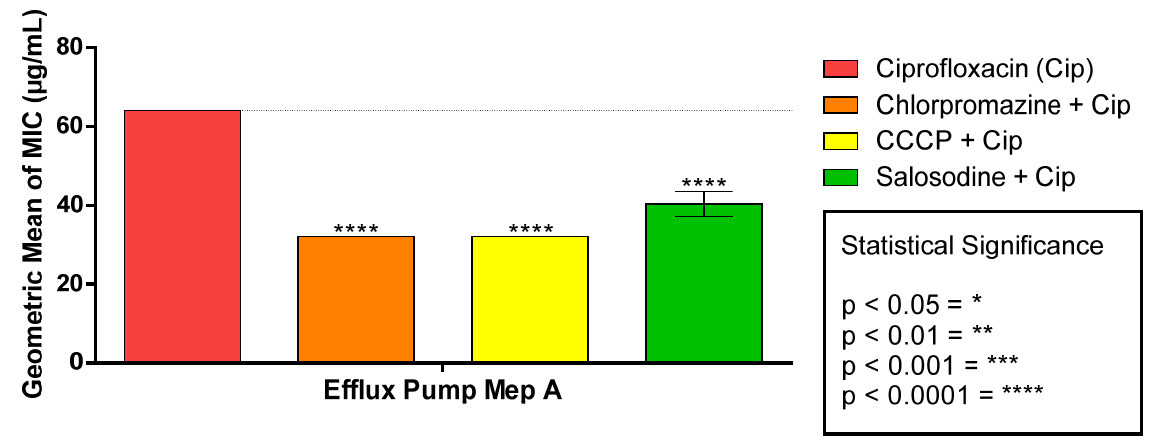
Figure 4. Modifying effect of norfloxacin antibiotic action by solasodine on S. aureus strain K2068. The solasodine associated with ethidium bromide expressed an antagonistic effect, having a high increase in the MIC. The bromide in conjunction with the standard inhibitors showed a reduction in the MIC (Figure